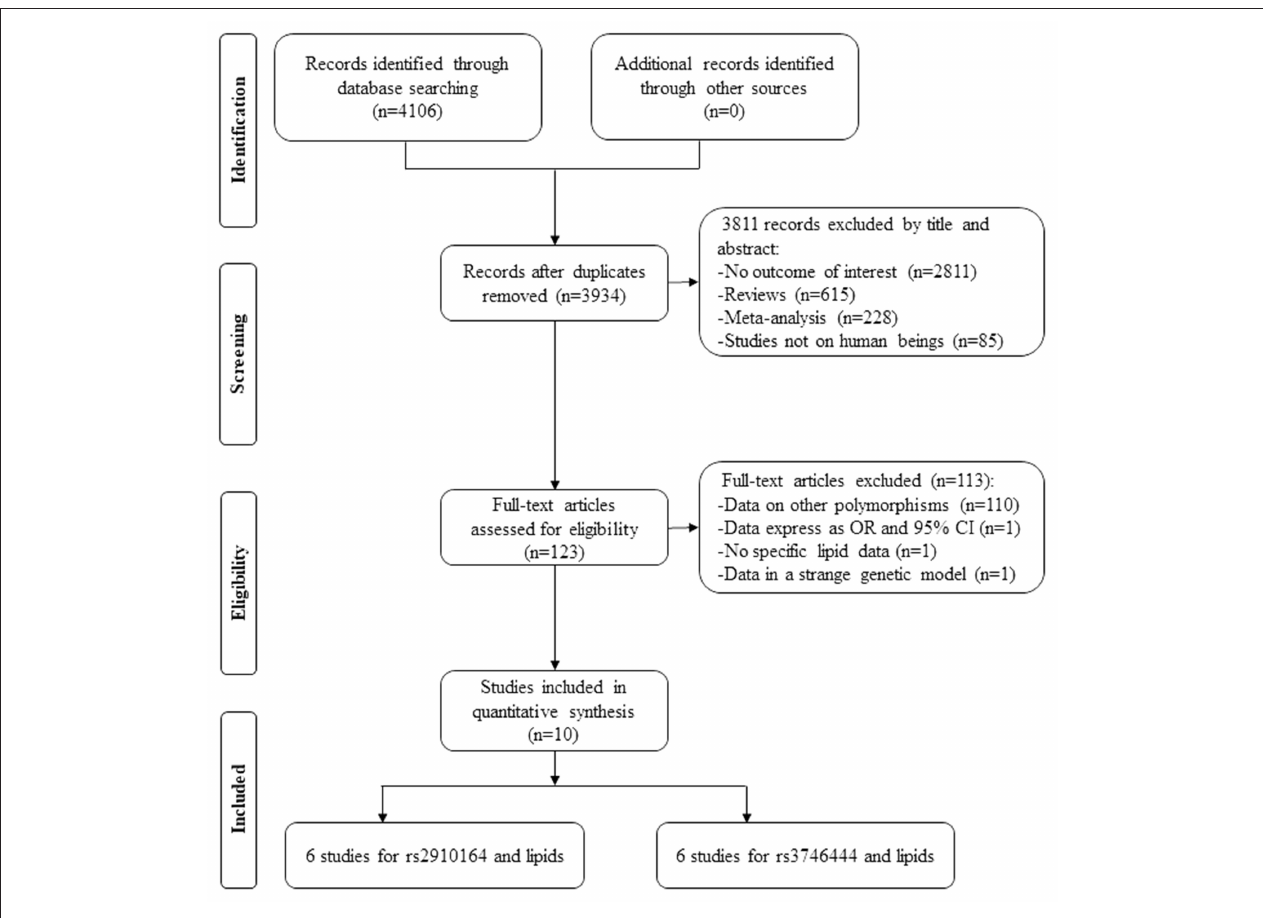
FIGURE 1 | Flow diagram of the articles selection